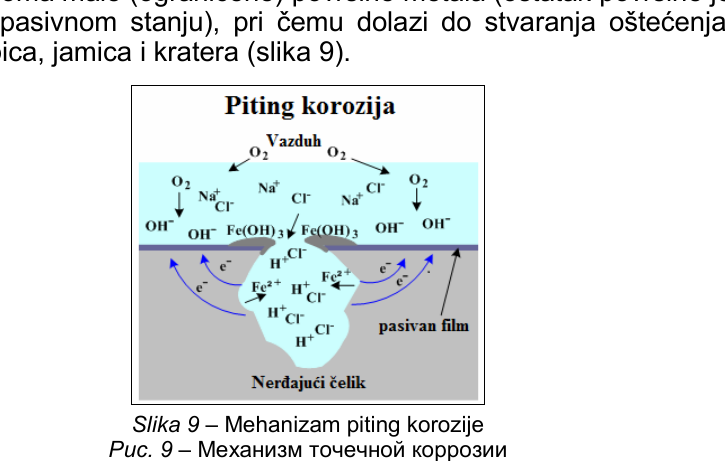
Figure 9 – The mechanism of pitting corrosion